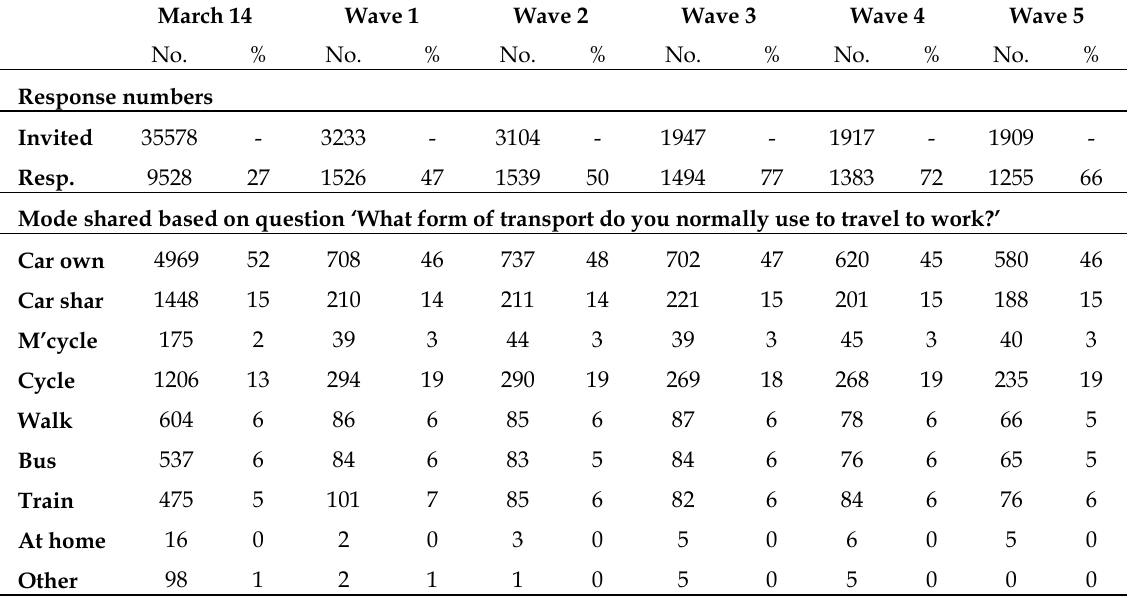
Table 1. Response numbers and mode share for travel to work in March 2014 and panel